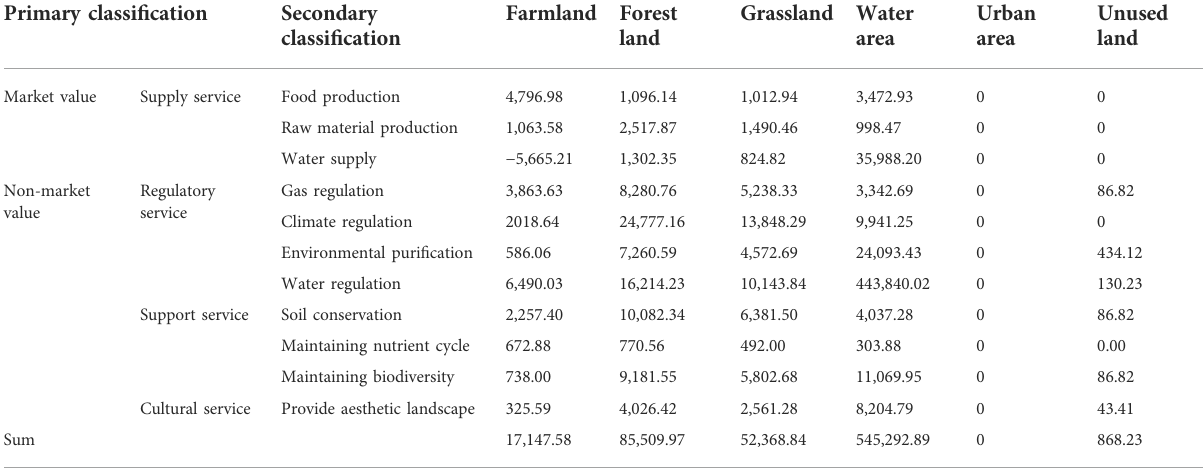
TABLE 2 Ecological service value per unit area of different ecosystems in the